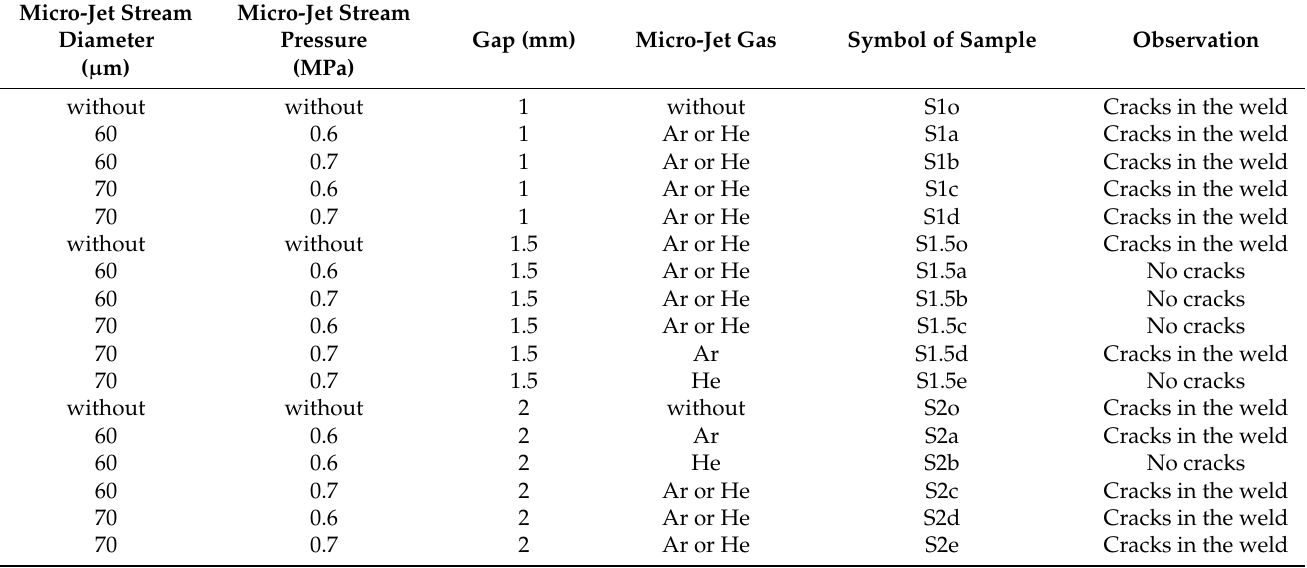
Table 2. Results from non-destructive investigations, the joint application-movable platform. Micro-Jet